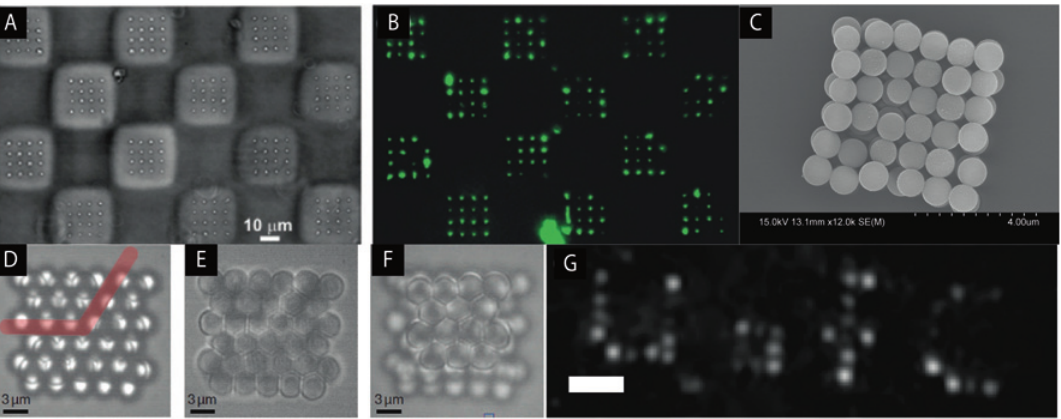
Figure 8: Micro andnanofabricationusingOT.(A – B) Arraysof E.coli assembledusingOTandphotopolymerization.After5 h,83%of cells are still viable, as determined from fl uorescence imaging in (B). Reprinted with permission from Ref. [124]. (C) Two-layer simple cubic lattice consistingofalternatingbiotin-andavidin-coated1 μ mpolystyrenespheres[125].(D – F)Three-layerfacecenteredcubiccrystalassemblywith linedefectcomposedof3 μ mpolystyrenespheres.ReprintedwithpermissionfromRef.[102].(G)Dark fi eldmicroscopeimageofpatterned “ U of C ” using ∼ 40 nm gold nanoparticles. Reprinted with permission from Ref. [126].